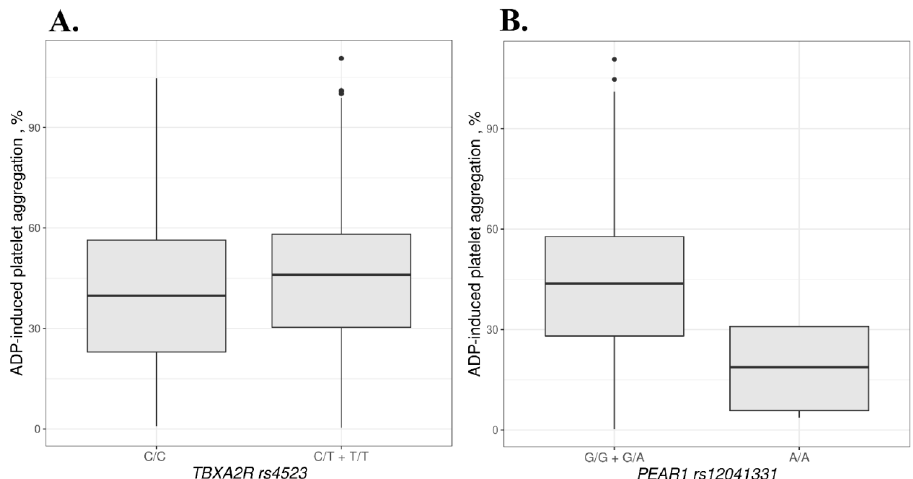
Figure 3. ADP-induced aggregation based on the TBXA2R rs4523 ( A ) and PEAR1 rs12041331 ( B ) genotypes. Dots beyond the whiskers indicate the